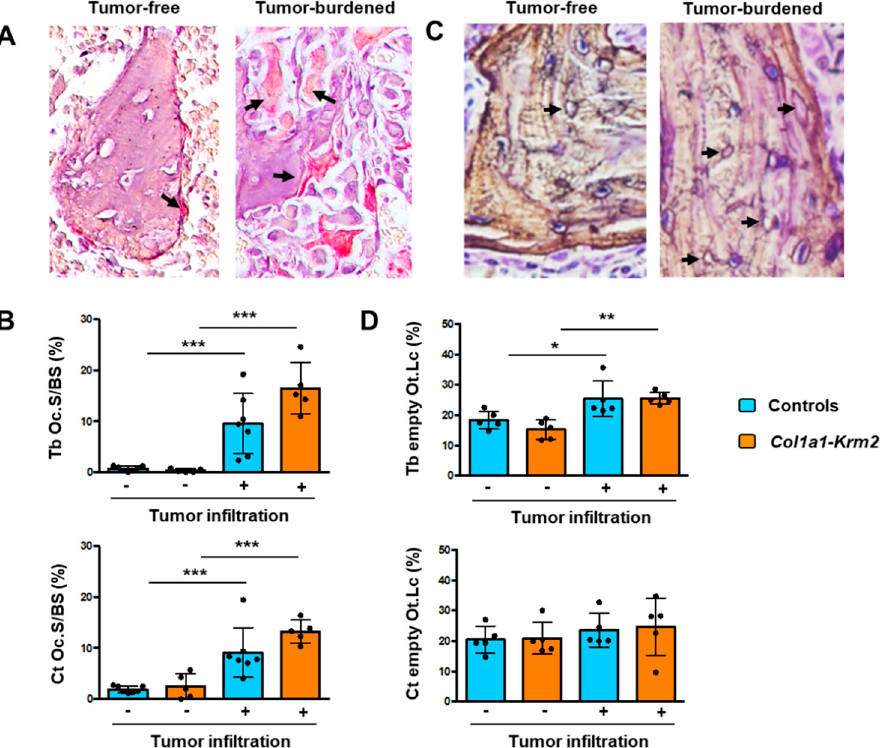
Figure 5. MDA-MB-231-SCP2 metastases affect osteoclastogenesis and the osteocyte network. ( A ) Representative TRAP activity staining of osteoclasts (arrows) on spine sections from an NSG mouse three weeks after injection of MDA-MB-231-SCP2 cells. The left panel represents a trabecular bone area without tumor cell infiltration, whereas the right panel shows trabecular bone in a tumor-burdened area. Arrows indicate TRAP-positive osteoclasts. ( B ) Quantification of the osteoclast surface per bone surface (Oc.S/BS) at trabecular (Tb) or cortical (Ct) bone in tumor-free ( − ) and tumor-burdened (+) areas from all experimental mice. ( C ) Representative silver staining of undecalcified spine sections from an NSG mouse three weeks after injection of MDA-MB-231-SCP2 cells. The left panel represents a trabecular bone area without tumor cell infiltration, whereas the right panel shows trabecular bone in a tumor-burdened area. Arrows indicate empty osteocyte lacunae. ( D ) Quantification of the percentage of empty osteocyte lacunae (Ot.Lc) within trabecular (Tb) or cortical (Ct) bone in tumor-free ( − ) and tumor-burdened (+) areas from all experimental mice. Data represent mean ± standard deviation ( n = 5). Statistical significance was determined by one-way ANOVA; * p < 0.05, ** p < 0.005, *** p < 0.0005.